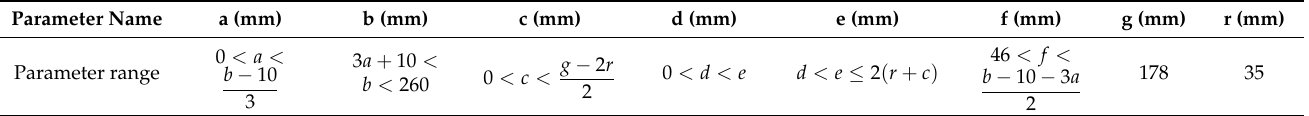
Table 1. Design parameters range of the lightweight drive rod.